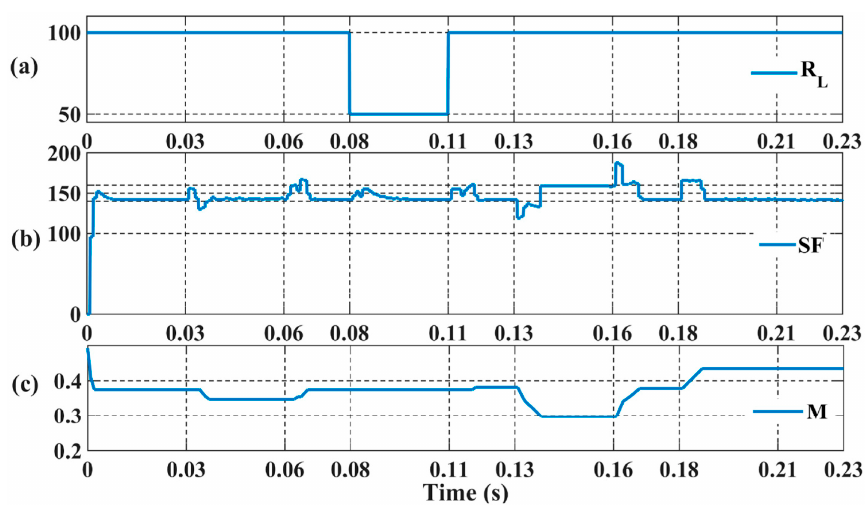
Figure 10. Performance of the proposed equivalent controller. ( a ) R L ; ( b ) SF; ( c ) M.